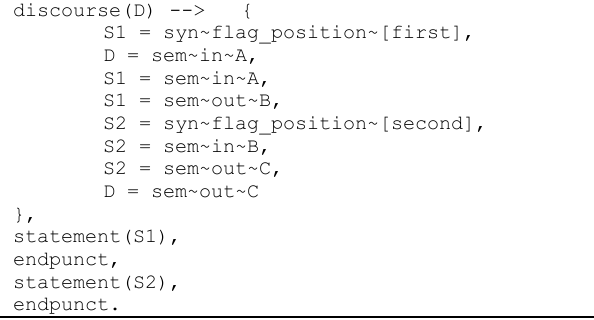
Figure 1. Split the original paragraph into two separate sentences based on framework GULP (Source: T. Tran and D. T. Nguyen